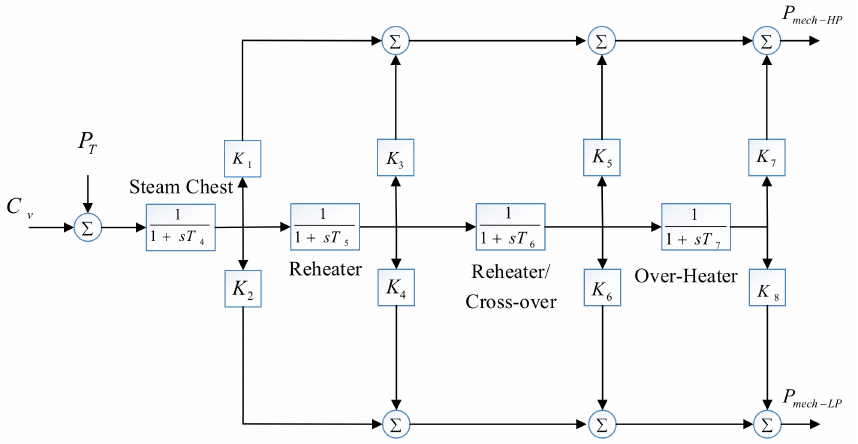
Figure 3. Dynamic model of a steam turbine